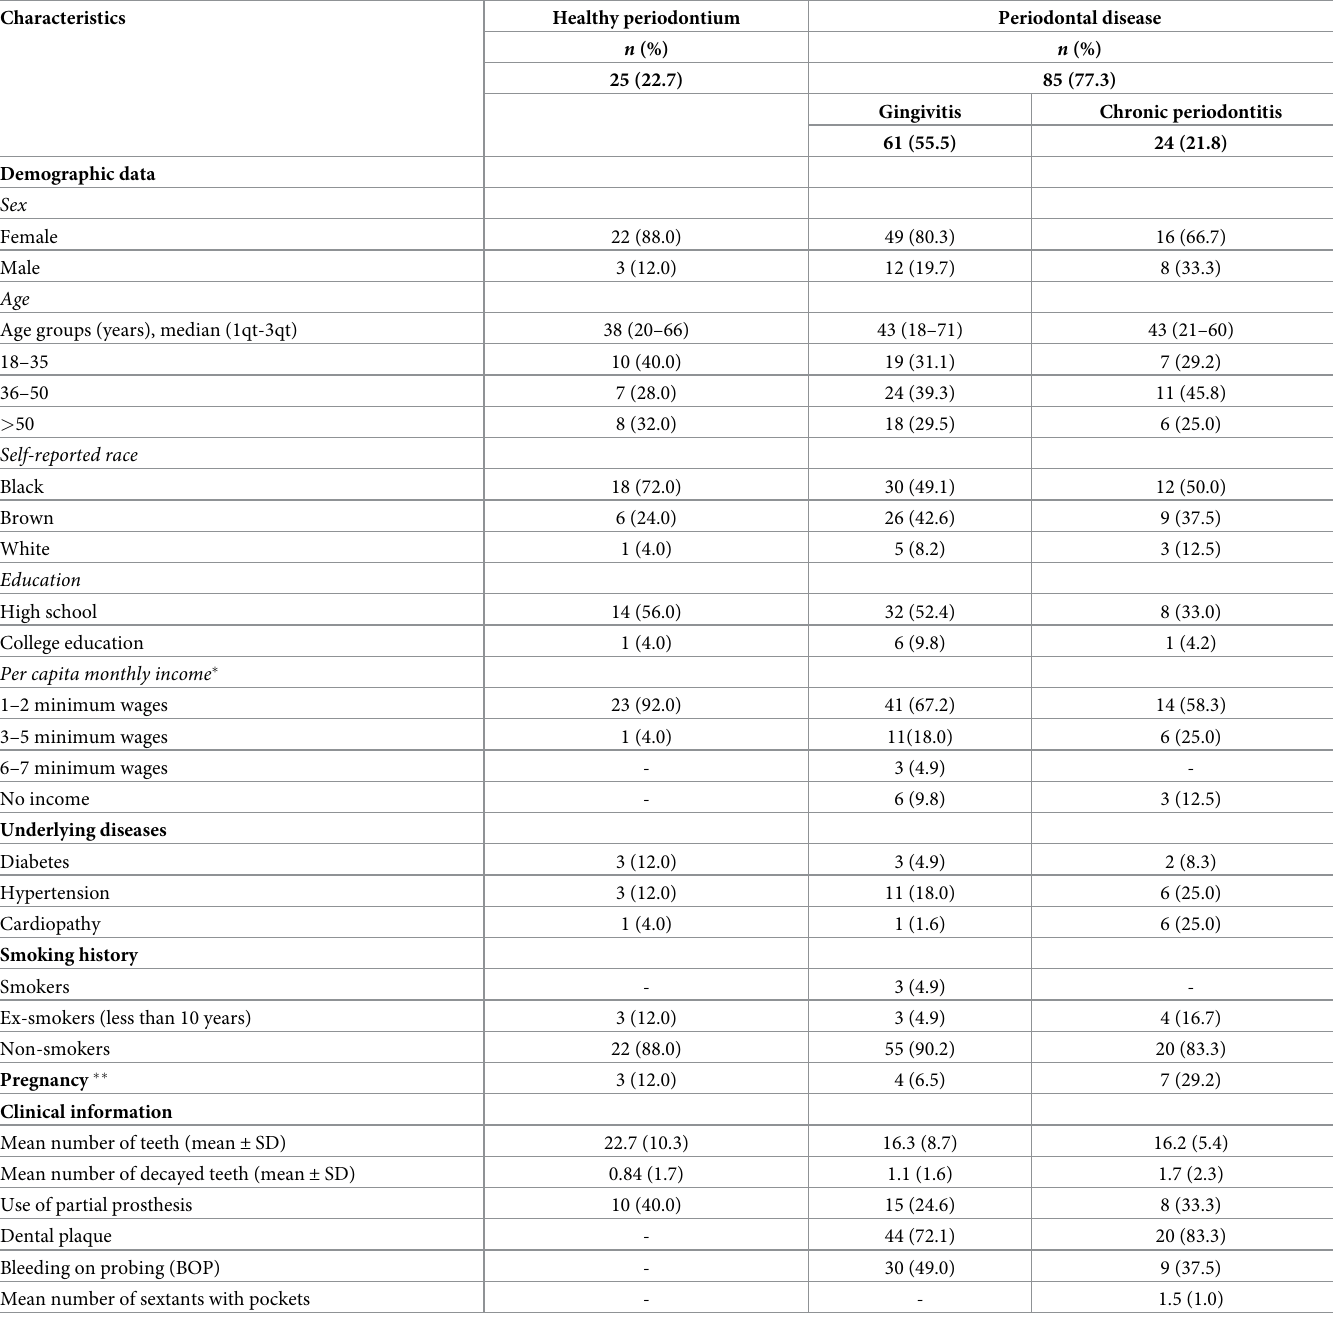
Table 1. Demographic and clinical features of patients stratified by periodontal health status ( n =